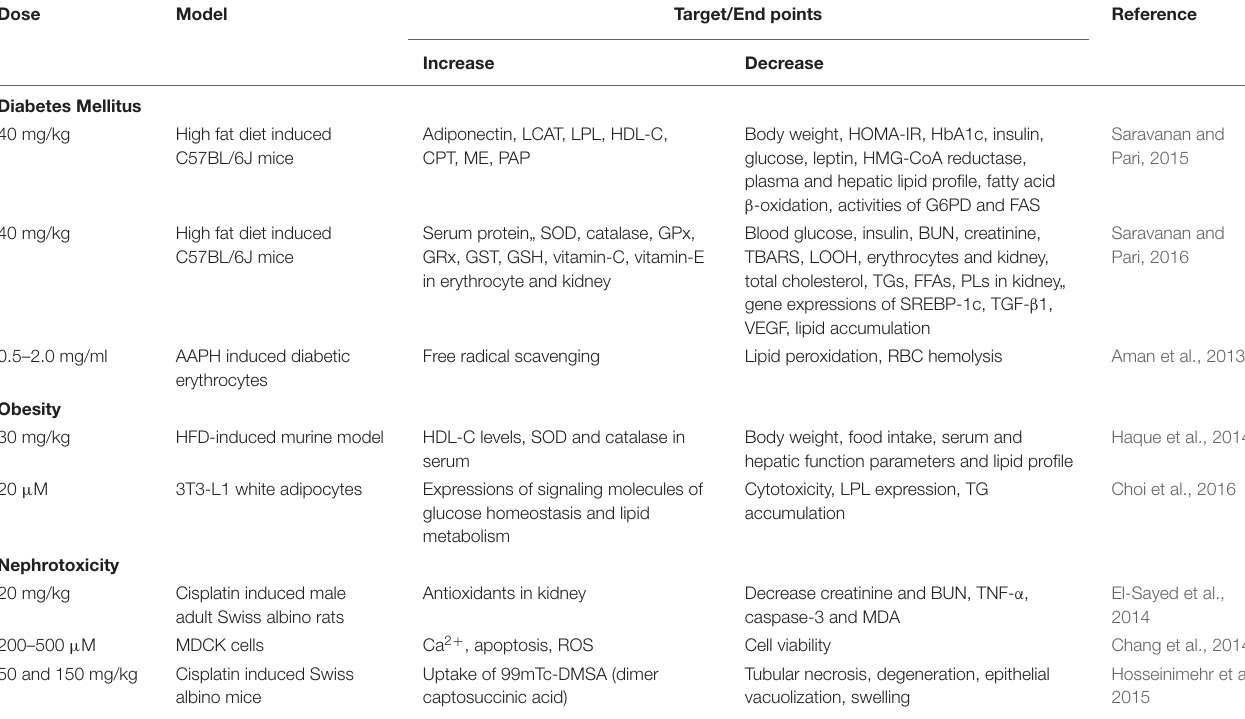
TABLE 3 | Effect of thymol in different experimental models of metabolic disorders and